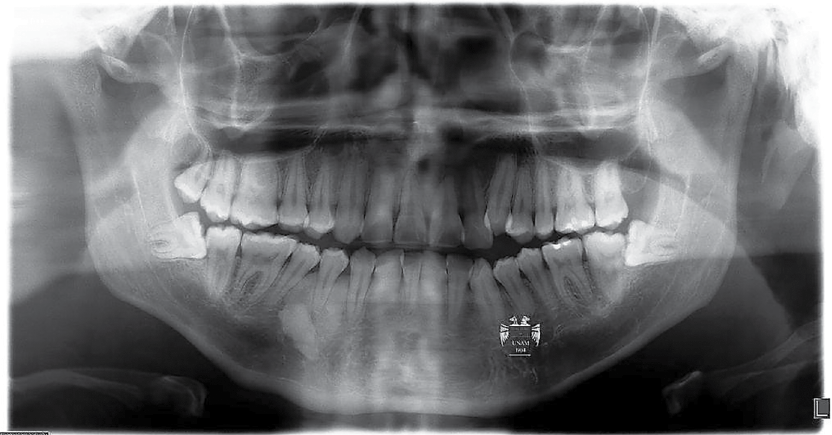
Figure 3- Case 2. Radiopaque giant lesion associated to a supernumerary right mandibular premolar. Two mandibular molars, two maxillary first molars and both maxillary lateral incisors are macrodonts. Additionally, left maxillary canine and both premolars are microdontic, including right mandibular second molar